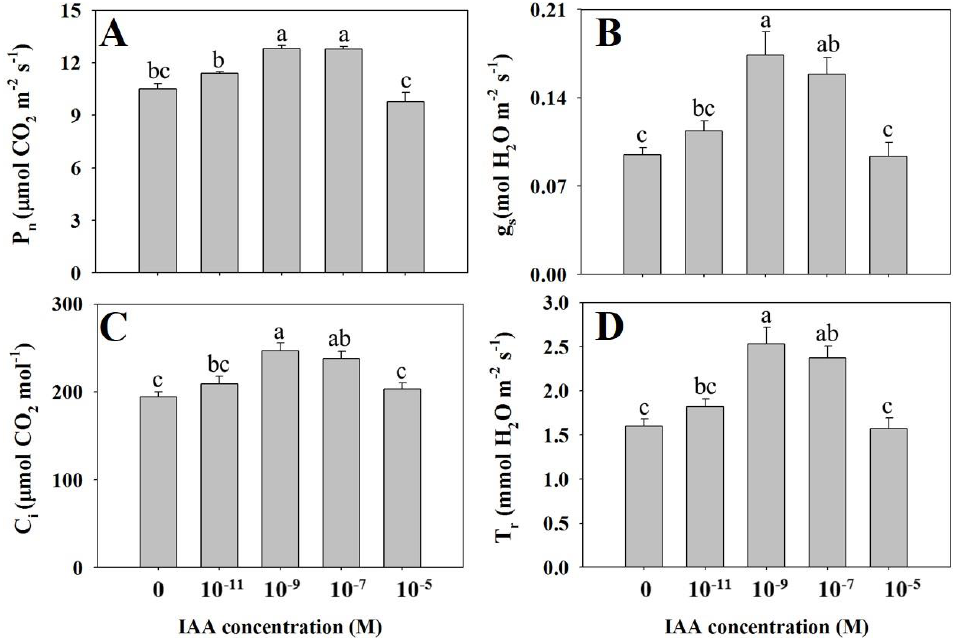
Figure 3. Net photosynthetic rate (P n ) ( A ), stomatal conductance (g s ) ( B ), intercellular CO 2 concentration (C i ) ( C ), and transpiration rate (T r ) ( D ) of A. rugosa subjected to the control (without IAA) and four IAA treatments. Different letters (a-c) indicate significant differences among treatments at p ≤ 0.05 ( n =